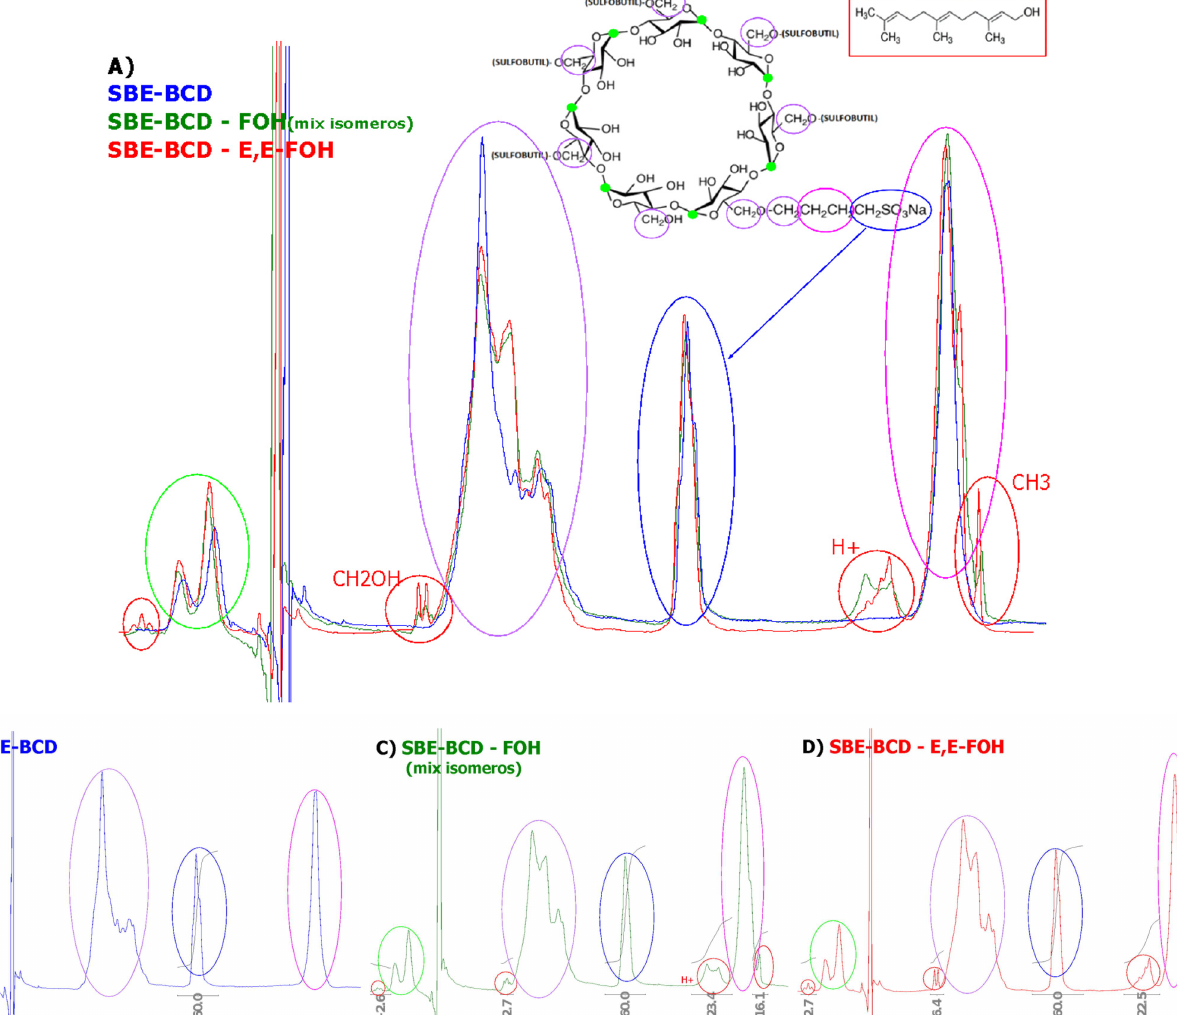
Figure 2. NMR Spectra of SBE- β -CD ( B ), complex with FOH isomer mixture ( C ), complex E , E -FOH ( D ), and its comparative ( A